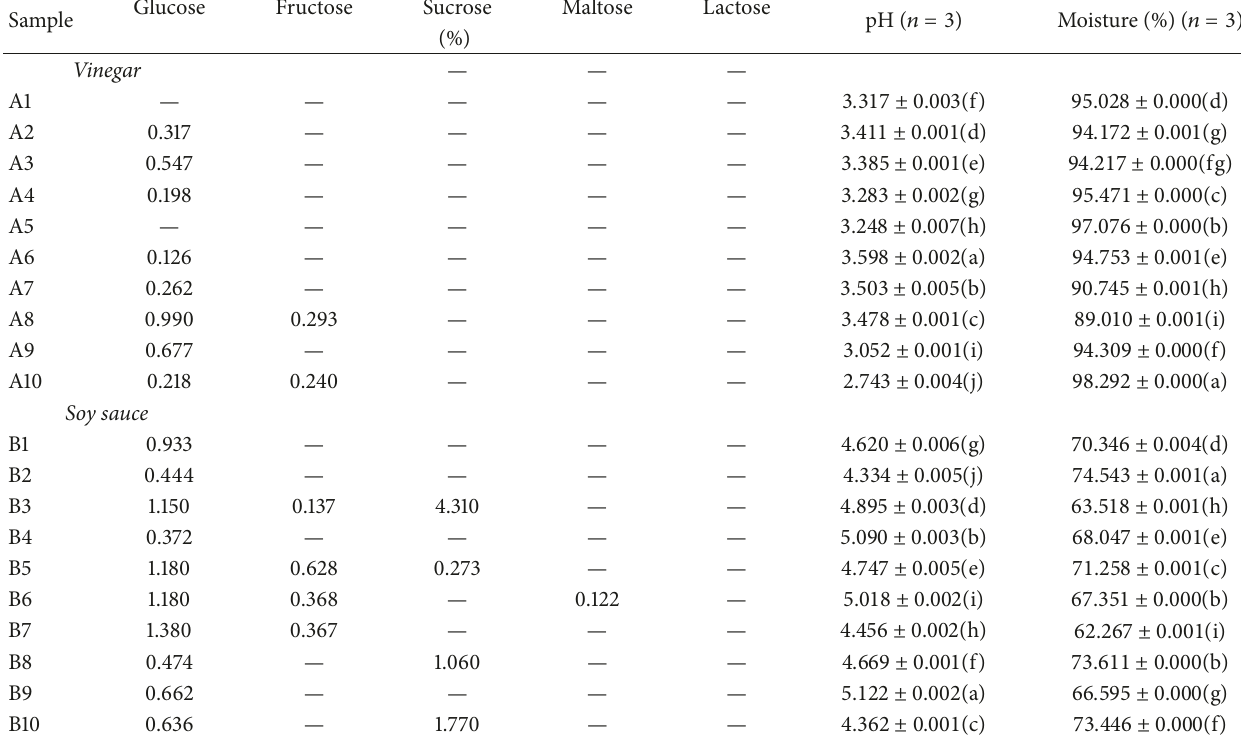
Table 1: pH value, sugar, and moisture contents in vinegars and soy sauces.